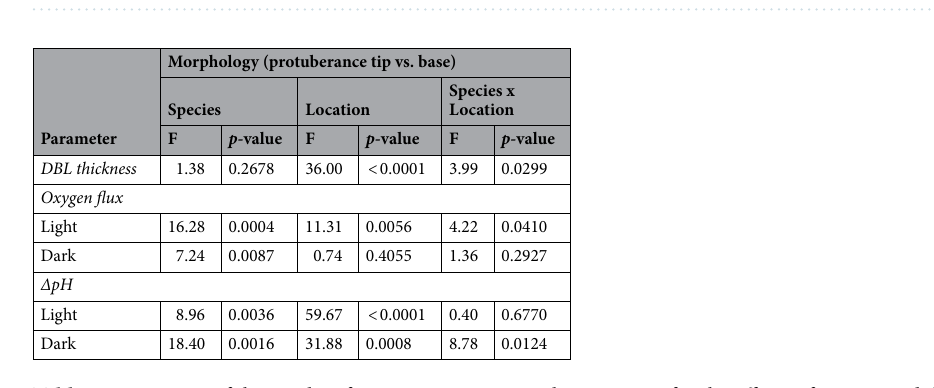
Table 1. Summary of the results of two-way ANOVA analyses, testing for the effects of species and their respective morphology (location- protuberance tip vs. base) on DBL thickness and the associated biochemical gradients. Significant differences ( p < 0.05) are indicated in